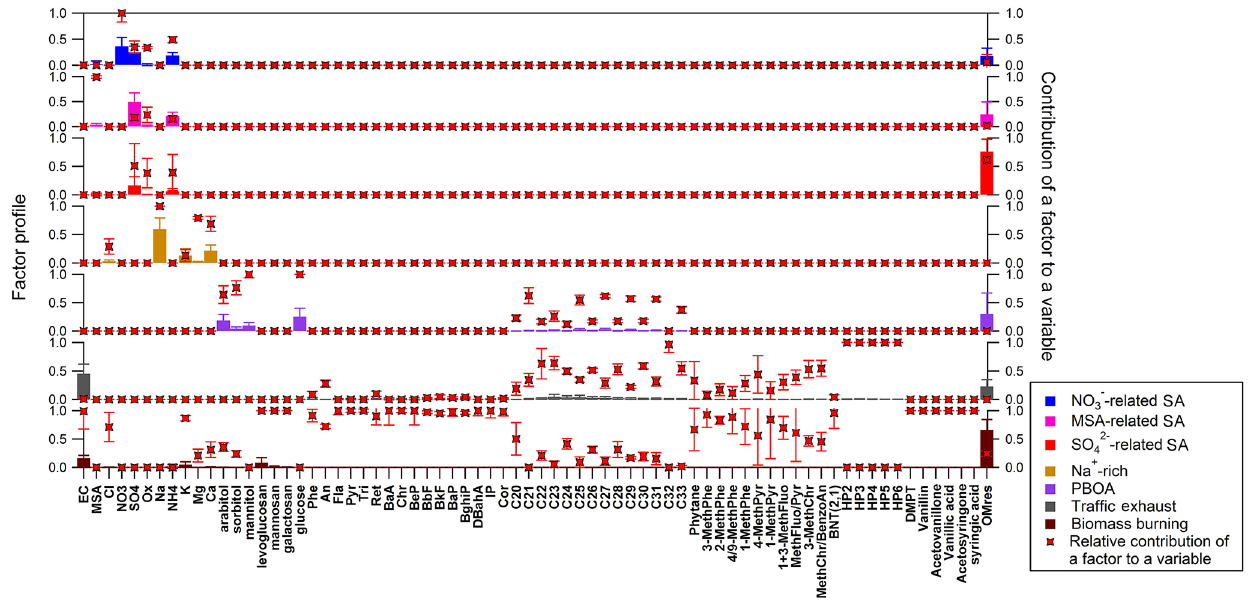
Figure 4. Marker-PMF factor profiles (bars) and relative contributions of the factors to the measured variables (symbols). SA is secondary aerosol; PBOA is primary biological organic aerosol.